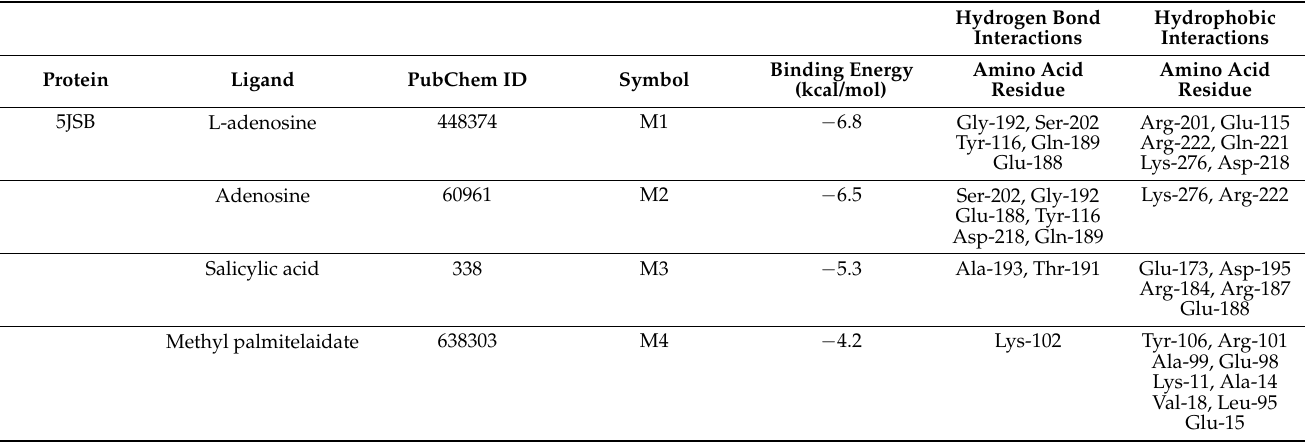
Table 6. Binding energy of potential active compounds on MCL1 (PDB ID: